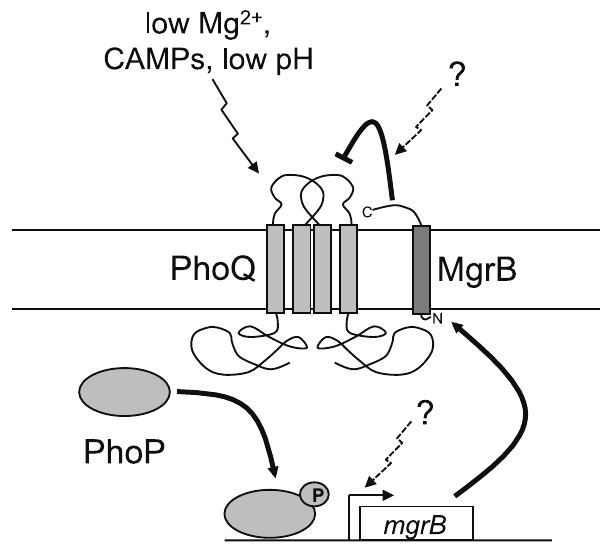
Figure 8. MgrB mediates negative feedback in the PhoQ/PhoP system. PhoQ stimulation by low extracellular magnesium or cationic antimicrobial peptides (CAMPs) leads to increased levels of phosphor- ylated PhoP, which in turn results in increased transcription of mgrB . MgrB inserts in the inner membrane, with its N-terminus in the cytoplasm and C-terminus in the periplasm, and represses PhoQ, resulting in decreased PhoP phosphorylation. The question marks illustrate potential points of control where additional signals could modulate PhoQ/PhoP signaling by regulating MgrB activity or